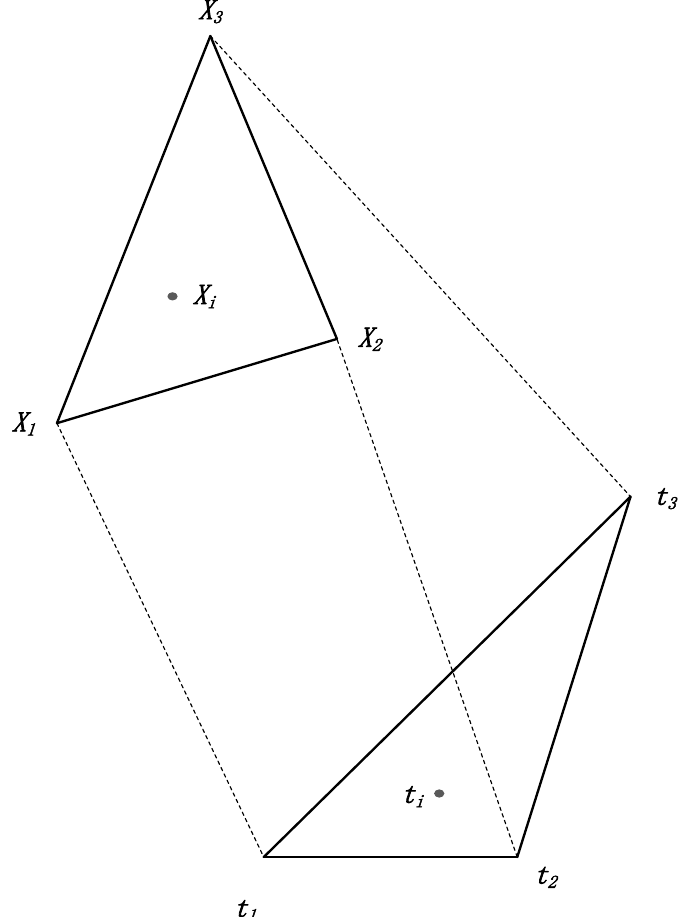
Figure 4. The mapping relationship between texture triangles and model triangles. In Figure 4, t 1 , t 2 , and t 3 are the three normalized vertex coordinates of the texture triangle, respectively. X 1 , X 2 , and X 3 are the spatial plane coordinates of the model triangle, respectively. t i is the normalized texture position corresponding to the extracted feature (cid:3) T (cid:2) X w Y w Z w point. X i = is the spatial position corresponding to t i . According to the corresponding relationship between the model triangle and the texture triangle, the plane coordinates of texture triangle and model triangle are defined as a 2D affine transformation, which can be expressed as Equation (2).